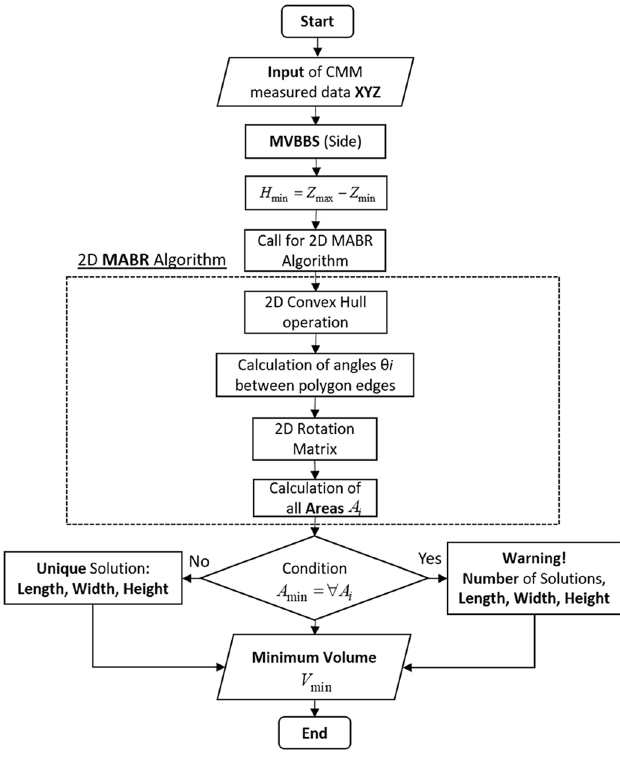
Fig. 5. The fl owchart of the MVBBS method with the MABR